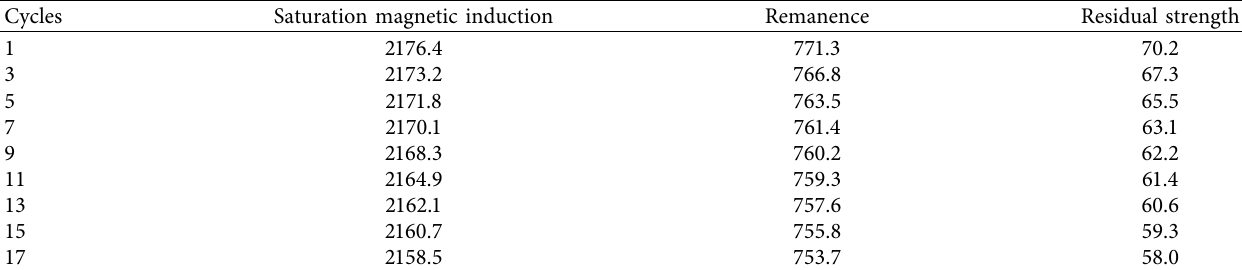
Table 3: The relationship between fatigue damage and magnetic parameters.